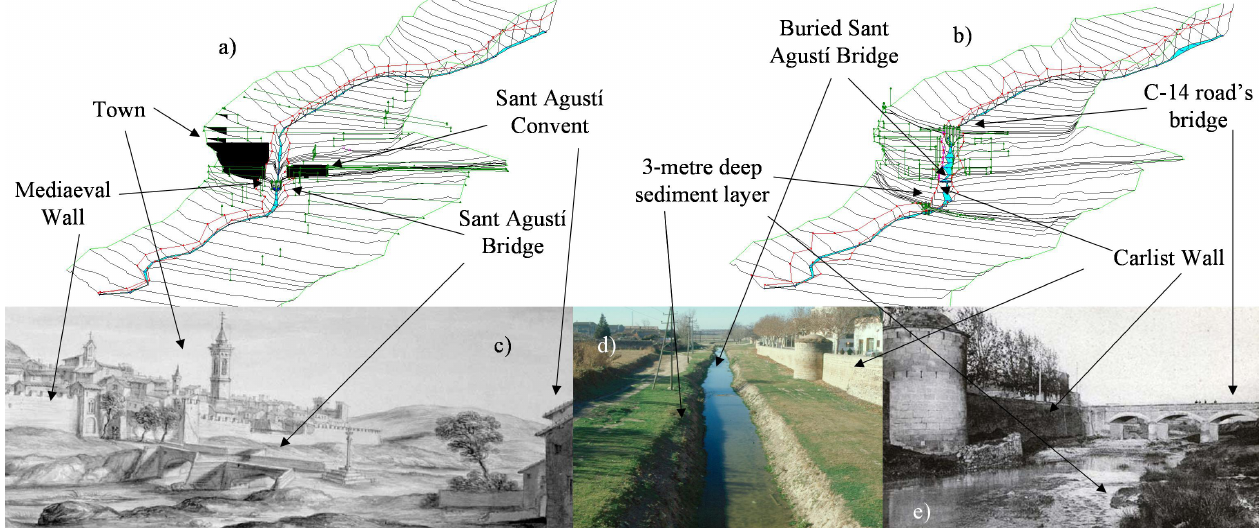
Fig. 3. Two of the three morphology scenarios used in the modelling: scenario A (a) and scenario C (b) including the 53 cross-sections and their main morphology features, illustrated by: Pier Maria Baldi’s 1668 drawing (c) , a 2007 downstream view from the C-14 road’s bridge (d) , and a 1905–1915 upstream view of the Ondara River in T`arrega and the C-14 road’s bridge (e)